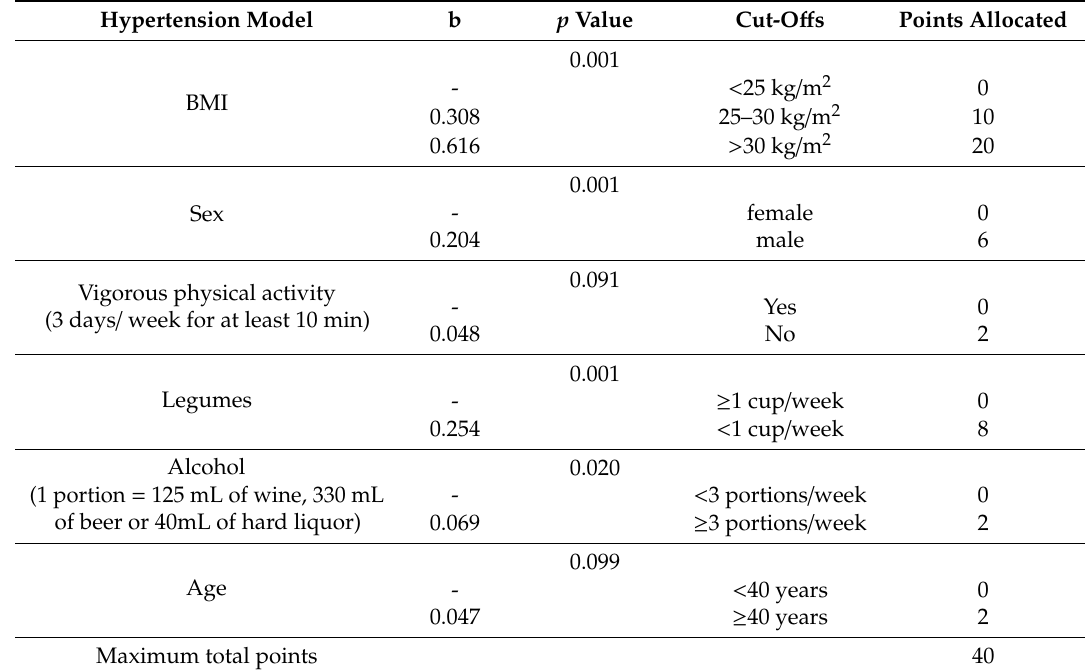
Table 3. Scores for European HTN Risk Index.